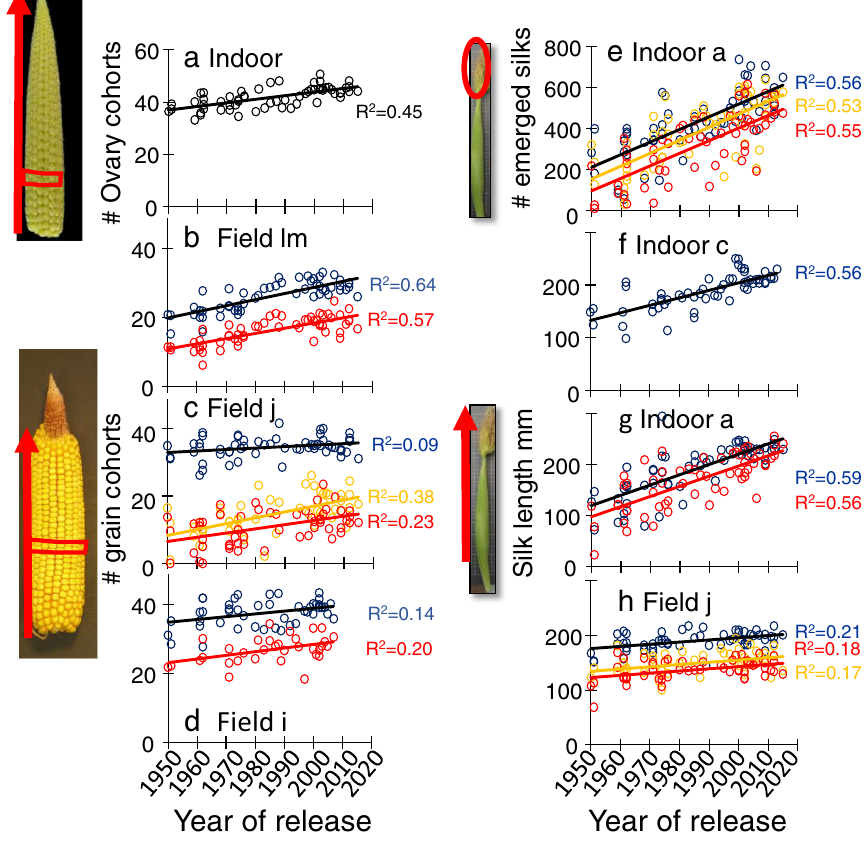
Fig. 7 Traits related to reproductive development changed with similar rates in all studied environments. a Number of ovary cohorts, initiated from the base of the ear (red arrow). b – d Number of grain cohorts. e Number of silks extruding from the husks at anthesis. f – h Silk length at anthesis, from insertion point to their tip. In b , blue and red dots for the water scenarios of multi-site experiments as in Fig. 1. In c , blue, orange, and red dots: well-watered, medium water de fi cit and strong water de fi cit. In d , blue and red symbols: well-watered and water de fi cit. One dot per hybrid (BLUEs). In e – h , blue dots for well- watered (soil water potential higher than − 0.1 MPa), red dots for water de fi cit, green triangle for well-watered plants with heat stress and orange dots for intermediate soil water de fi cit. a – h One dot per hybrid (BLUEs). Regression lines are drawn when slopes are signi fi cant ( p < 0.01). Source data and p -values in Supplementary data